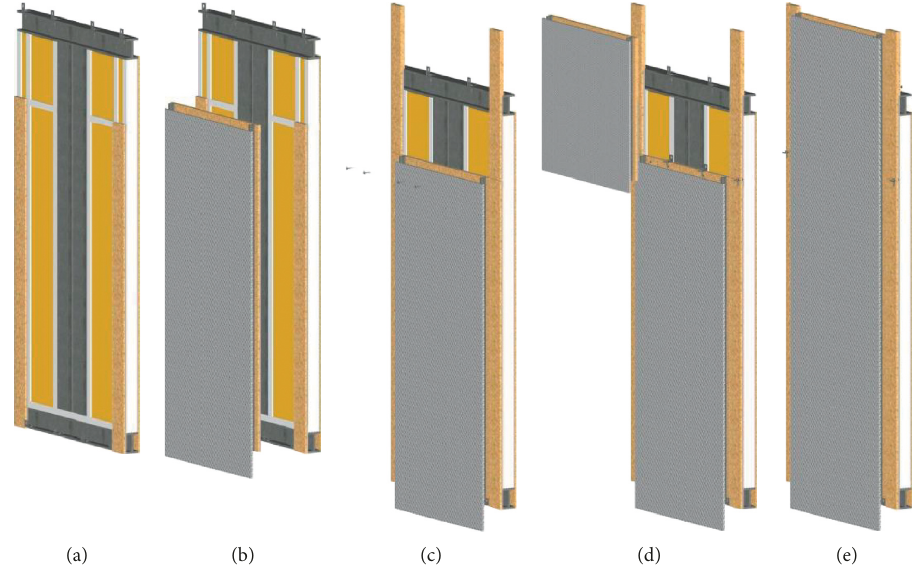
Figure 10: Installation instructions for an integrated building envelope using AB (source: authors’ own data). (a) The foundation wall at the junction of two modules; (b) integrated wall including exterior decoration, heat preservation, and structural plates; (c) fix integrated wallboard by self-tapping pin; (d) install the upper (parapet) wall; (e) finish.